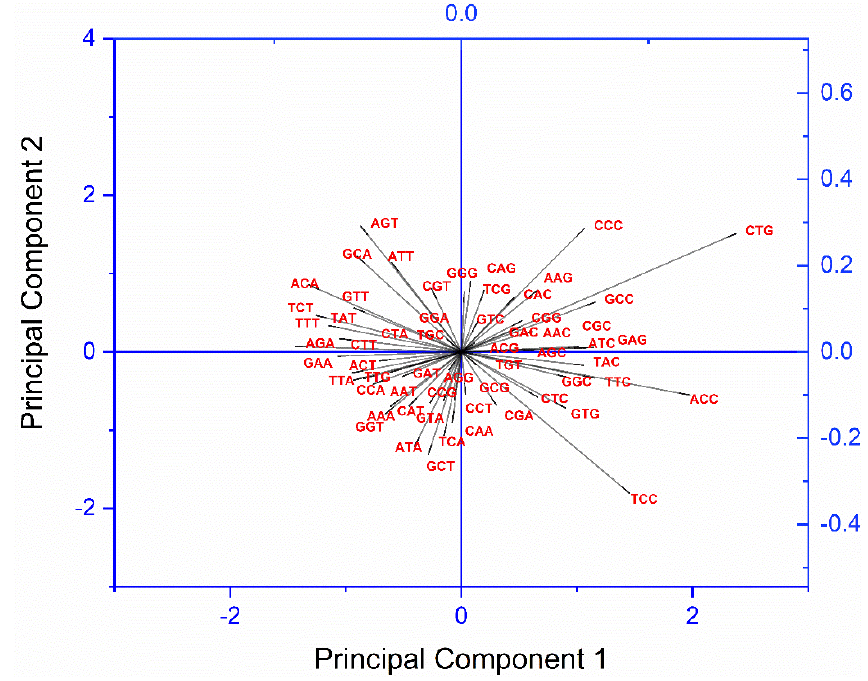
Figure 2. PCA biplot analysis revealed that CTG codon is maximally influencing the overall codon usage.